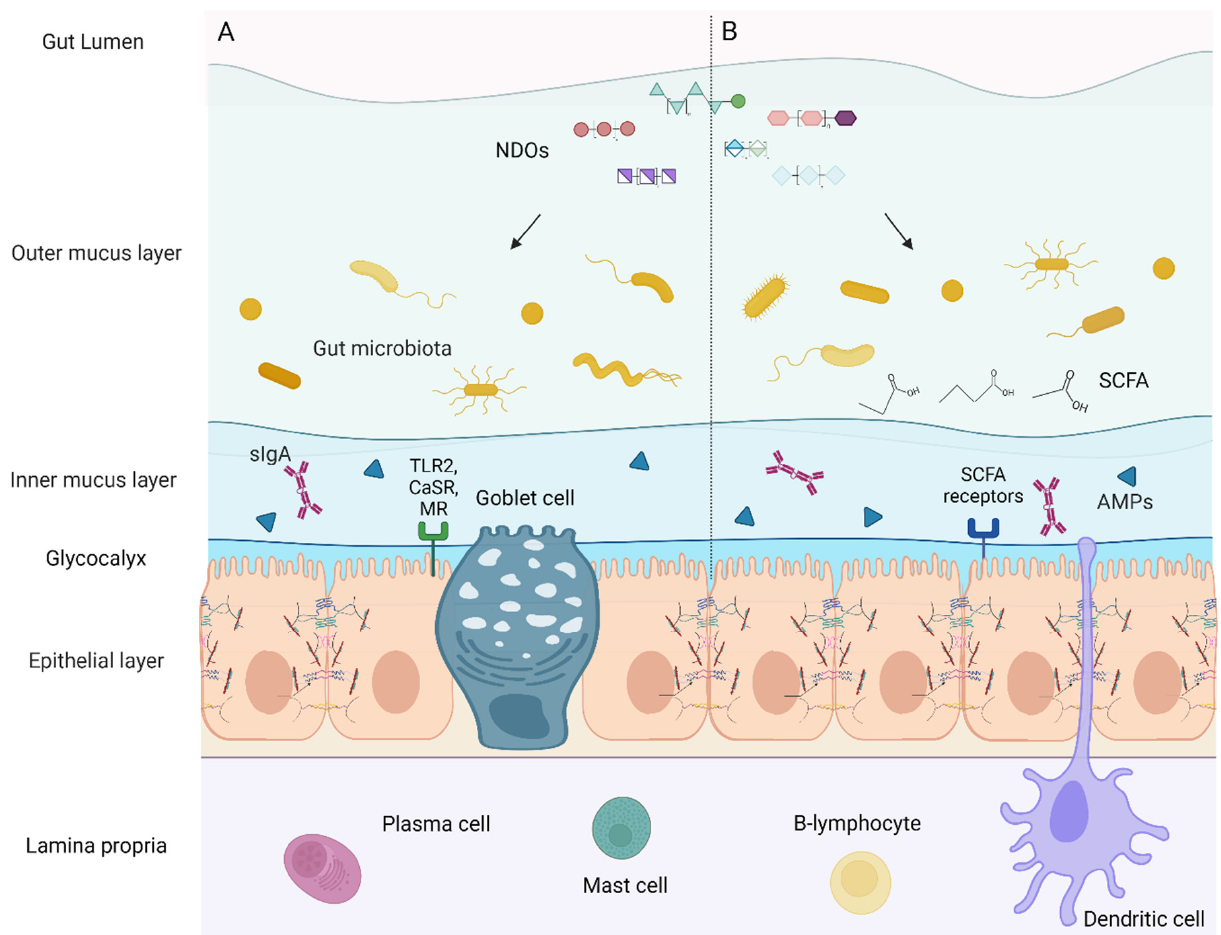
Figure 2. NDO-mediated regulation of TJs: The key elements of the mucosal barrier from the luminal to the basolateral surface are (1) the gut microbiota, (2) the outer and inner mucus layers containing plasma cell-originated sIgA, and the unstirred water layer, i.e., glycocalyx, (3) the epithelial monolayer mainly built of absorptive enterocytes, enteroendocrine cells, mucin-producing goblet cells, and AMP-producing Paneth cells, (4) the lamina propria comprised of IgA and cytokine-secreting innate and adaptive immune cells. Intercellular TJs connecting adjacent epithelial cells strictly regulate paracellular permeability and gut barrier integrity. The NDOs, once ingested, reach the colon intact and exert microbiota-independent ( A ) and -dependent ( B ) effects on the epithelial TJ complexes, thus modulating epithelial integrity. The microbiota-independent regulation of TJs results from direct interactions between NDOs and cell surface receptors of IECs or innate immune cells present in the lamina propria. Thereby, the NDOs reinforce the epithelial barrier via direct induction of host kinome responses (i.e., of the complete set of protein kinases encoded in an organism’s genome) and protect the integrity of the monolayer against noxious stimuli known for impairing TJ abundance and localization upon suppression of inflammatory responses ( A ). Concurrently, the NDOs enhance the mucosal barrier due to their prebiotic capability: First, they stimulate the growth of health-beneficial bacteria, which positively regulate TJs directly via their cell surface structures and excreted effectors. Second, NDO supplementation results in elevated concentrations of SCFAs (principally butyrate, acetate, propionate), which are the primary metabolites produced upon NDO fermentation by the gut commensals and are potent regulators of the epithelial TJs. Third, NDOs restore dysbiosis, a condition accompanied by leaky gut syndrome due to impaired TJ functionality. Re-establishment of balanced gut flora populations due to the decrease in pathogenic bacteria and the increase in beneficial ones leads to alleviation of intestinal inflammation and of the subsequent disruption of the epithelial barrier. Consecutively, NDOs enhance and protect mucosal barrier func- tion under normal and pathological conditions, respectively ( B ). Overall, NDOs can positively affect TJ localization and expression via their direct interactions with cell surface receptors and through their fermentation products. Created with BioRender.com. AJ, Adherens junctions; AMP, antimi- crobial peptide; IECs, Intestinal epithelial cells; NDO, Non-digestible oligosaccharide; SCFA, short- chain fatty acids; sIgA, Secretory immunoglobulin A; TJ, Tight junctions.